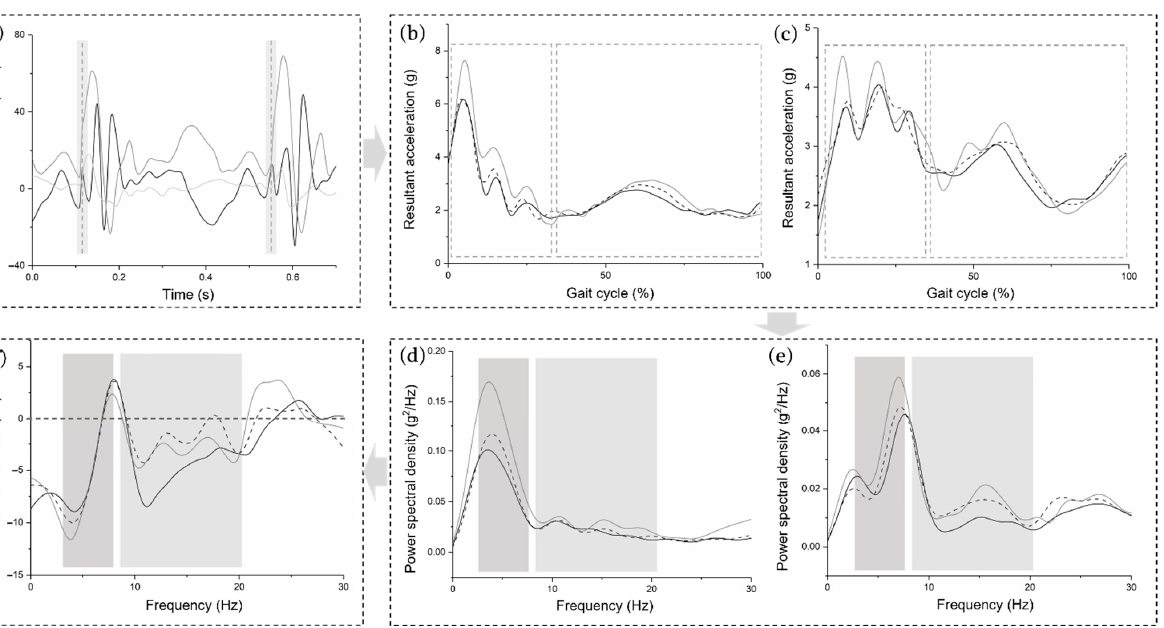
Figure 2. Graphical representation of the acceleration data process technique in the time and fre- quency domains. These include raw time-series tri-axis acceleration data ( a ); resultant acceleration from the distal ( b ) and proximal ( c ) tibia; power spectral density from the distal ( d ) and proximal ( e ) tibia; shock attenuation from the distal tibia to the proximal tibia ( f ). Note: black denotes maxi- malist shoes, gray denotes minimalist shoes, and the dashed line indicates conventional shoes.